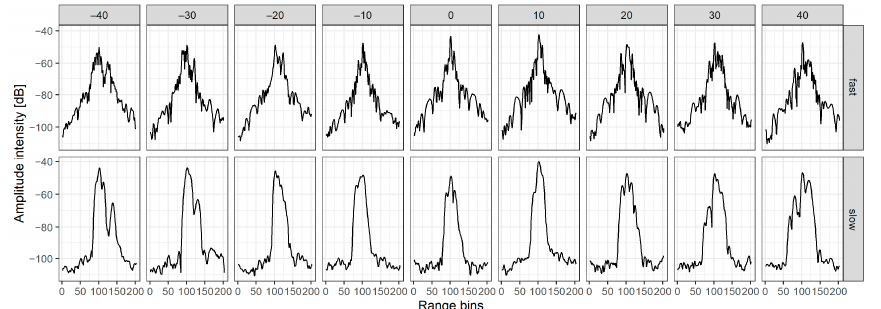
Figure 2. An example of raw amplitude data for a 295-mm-long bream observed in given dorsal orientations (0° correlates to the true dorsal aspect; negative angles correlate to the head tilted to- ward the transducer; positive angles correlate to the tail tilted toward the transducer) using fast- and slow-tapered acoustic pulses.